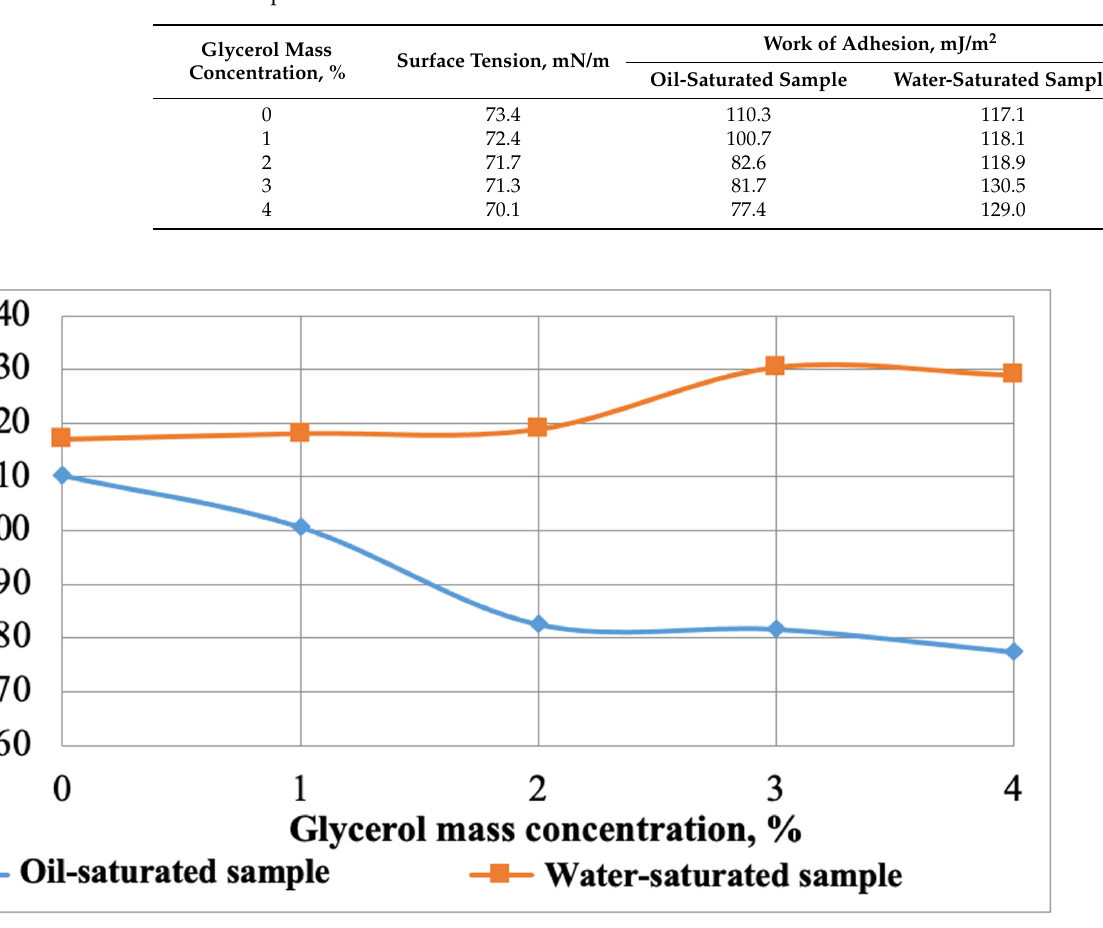
Table 1. Correlation between contact angle values of the shutoff composition and glycerol concen- trations.